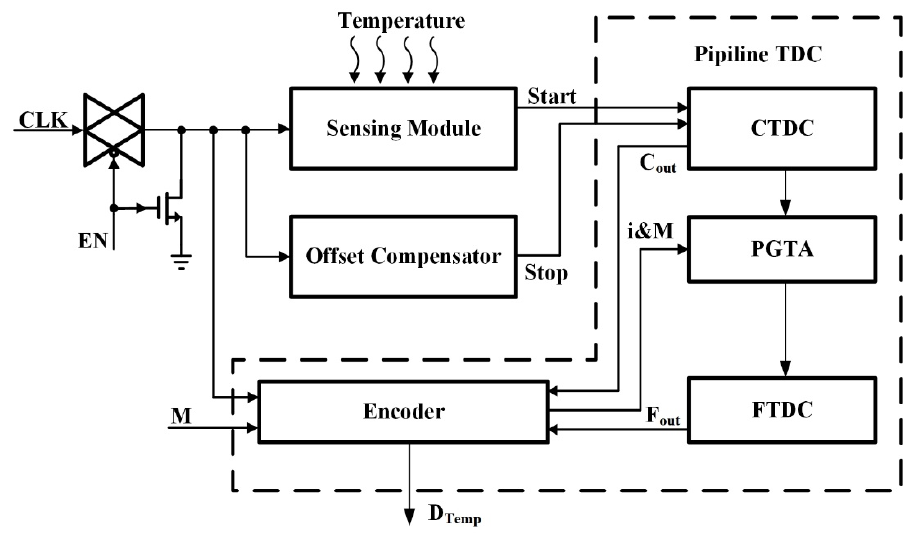
Figure 2. Block diagram of the temperature sensor.